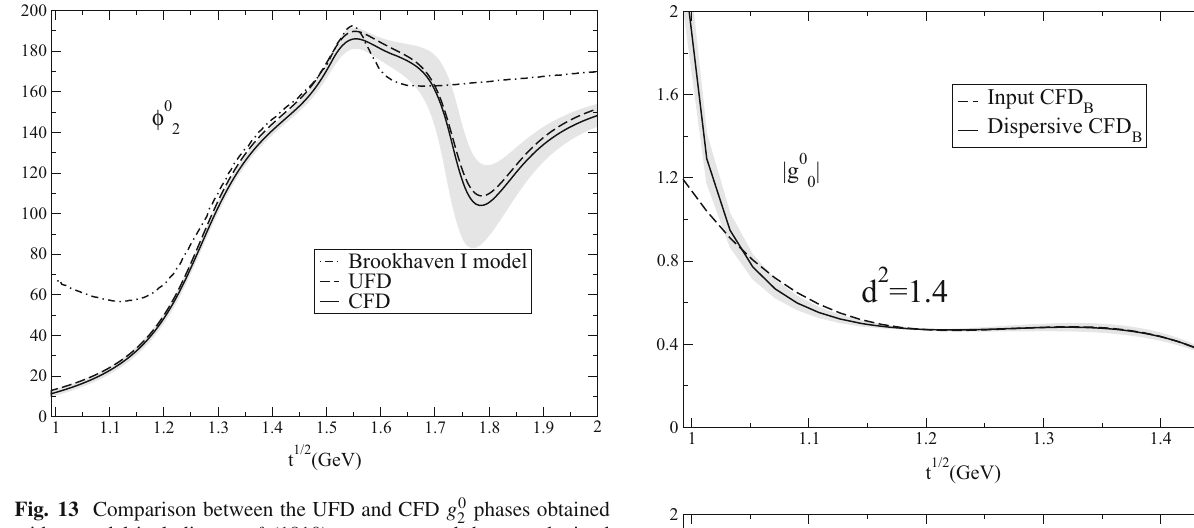
phases obtained 2